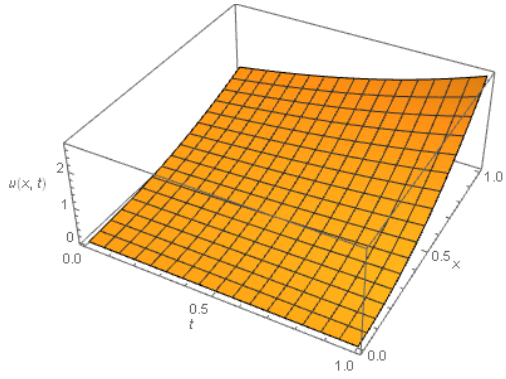
Figure 2:3D approximate Solution of Figure 1:3D exact Solution of example2 Figure 7. 3D approximate Solution of Example 2 with α = example2 with (cid:11) = 1 Figure 3:3D Solutions of example1 with di⁄erent with (cid:11) = 1 values of (cid:11)